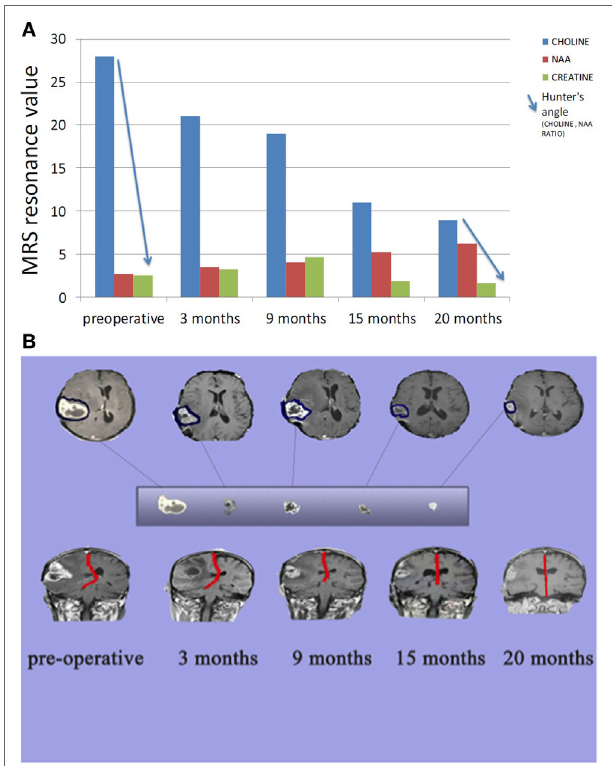
FiGURe 4 | (a) Comparison between tumor metabolism over 20 months. Choline indicates cell membrane turnover and reflects tumorigenesis. N-acetylaspartate (NAA) is a marker for neuronal integrity that decreases with brain malignancy and radio necrosis. Creatine is a marker for cellular energy that decreases significantly with malignancy and radio necrosis. Hunter angle (blue arrow) reflects the choline/NAA ratio. (B) Comparison between tumor size and midline shift (red line) over 20